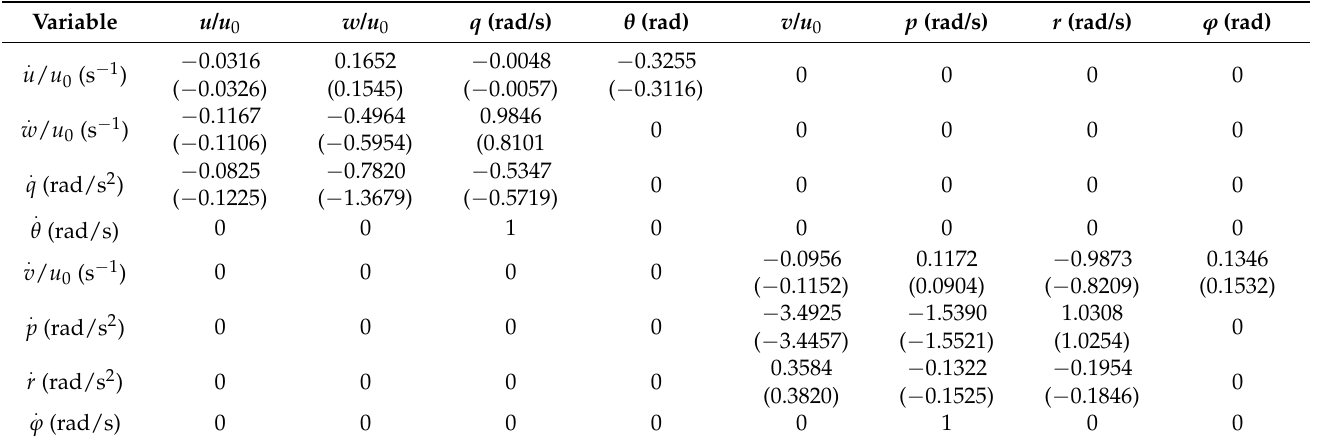
Table 26. CFD–RANS (extrapolated) 8 × 8 stability matrix for flight condition 20 in Tables 4 and 22 (reference takeoff case).